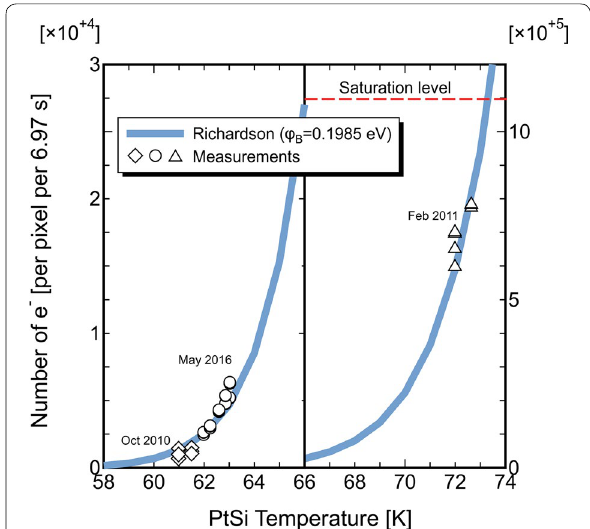
Fig. 4 Dark noise versus detector temperature of IR2. Dark measure‑ ments were taken on October 26, 2010, on February 28, 2011, and during May 10–24, 2016. The data are referenced to the measurement on May 22, 2016 (with the detector at 61.85 K), adjusted to 2300 electrons, the expected value according to Richardson’s equation. The solid curve is the theoretical value for the barrier height of 0.1985